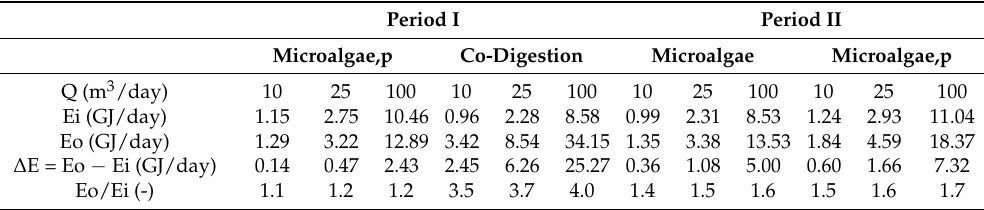
Table 4. Results of the energy assessment for the co-digestion and pretreated microalgae mono-digestion at 20 days of HRT, and for the untreated and pretreated microalgae mono-digestion at 30 days of HRT, with different flow rates (Q = 10, 25 and 100 m 3 /day). Ei (i.e., energy input) and Eo (i.e., energy